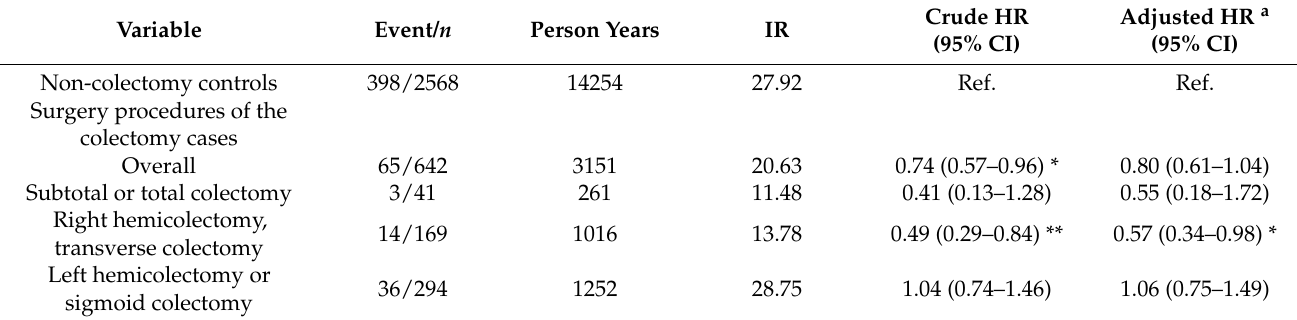
Table 4. Risk of type 2 diabetes following different colectomy procedures in patients without colorectal